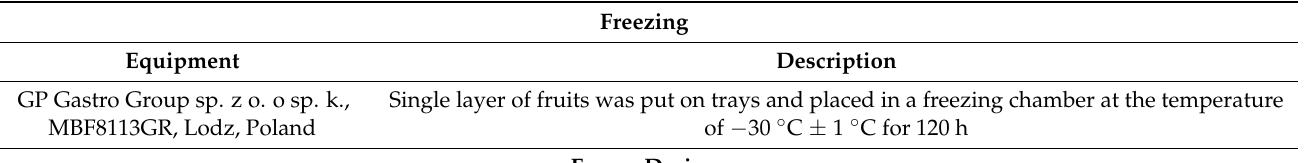
Table 2. List of equipment and parameters applied during preservation of the hawthorn